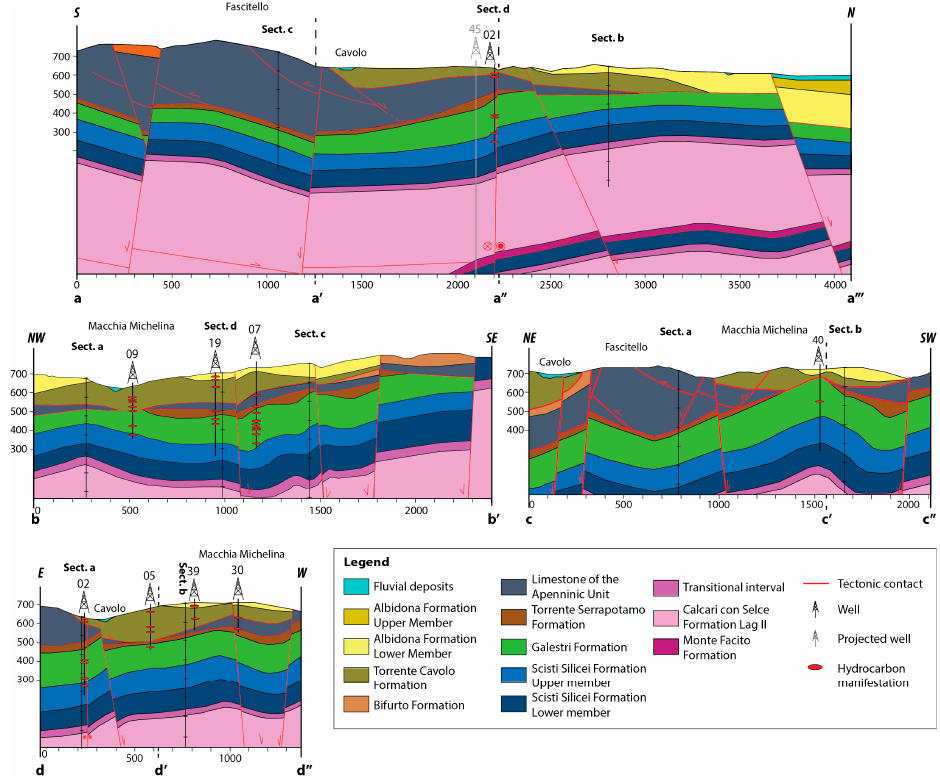
Figure 11. Geological cross-sections in the study area: section a-a ″′ , section b-b’, section c-c ″ and section d-d ″ . The traces of the cross-sections are reported in Figure 5.